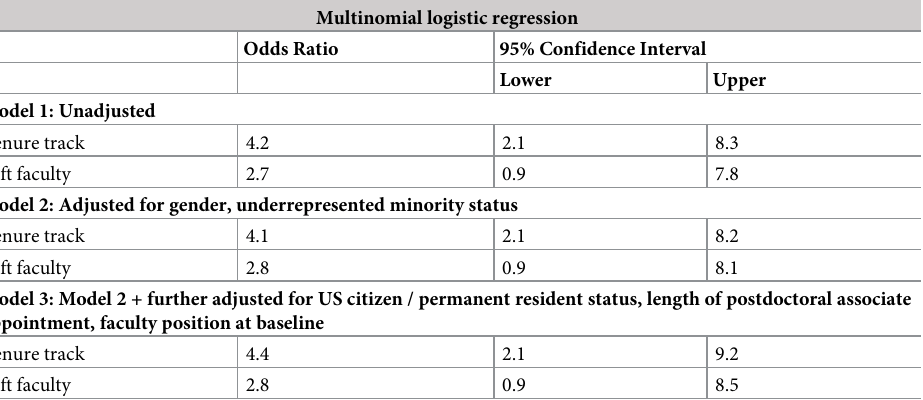
Table 2. Association of cross-institutional mobility (CIM) at baseline with tenure track faculty position status at 3-year follow-up among 238